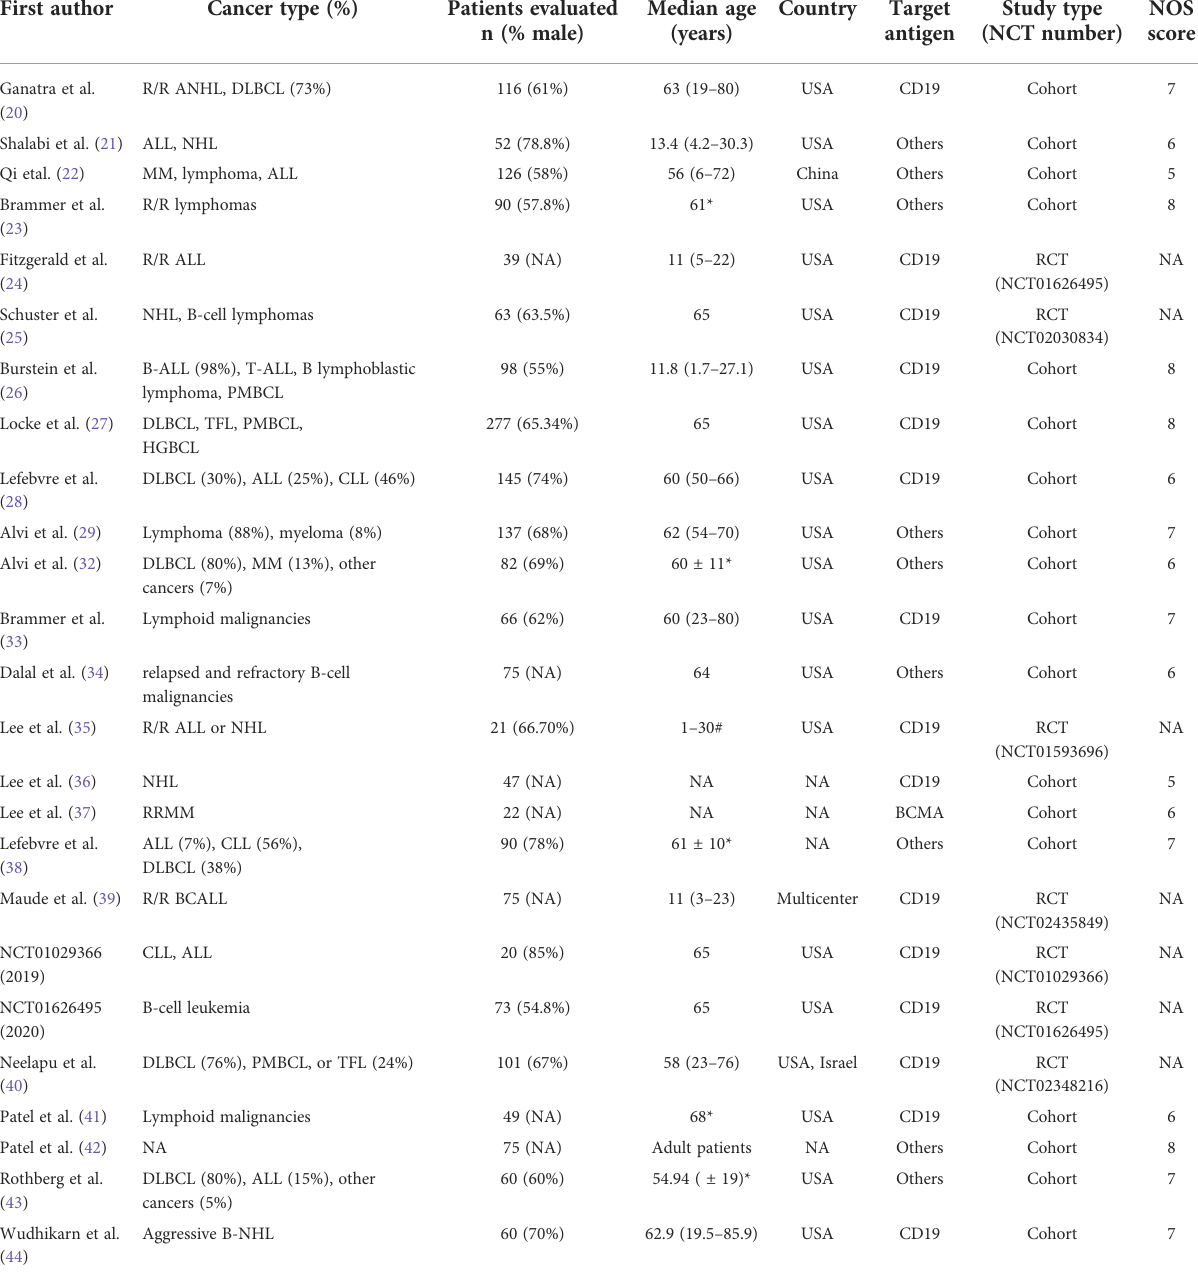
TABLE 1 Characteristics of the included studies and